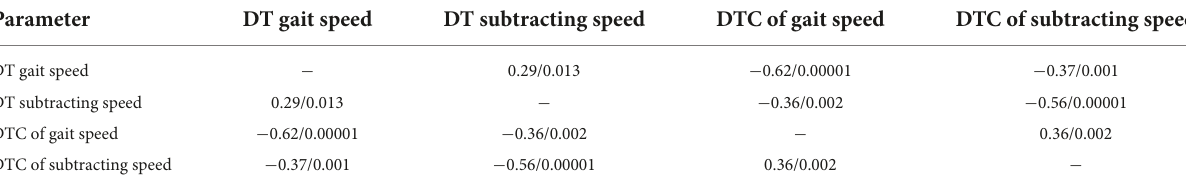
TABLE 2 Partial correlation between the dual-tasking parameters adjusted for age and